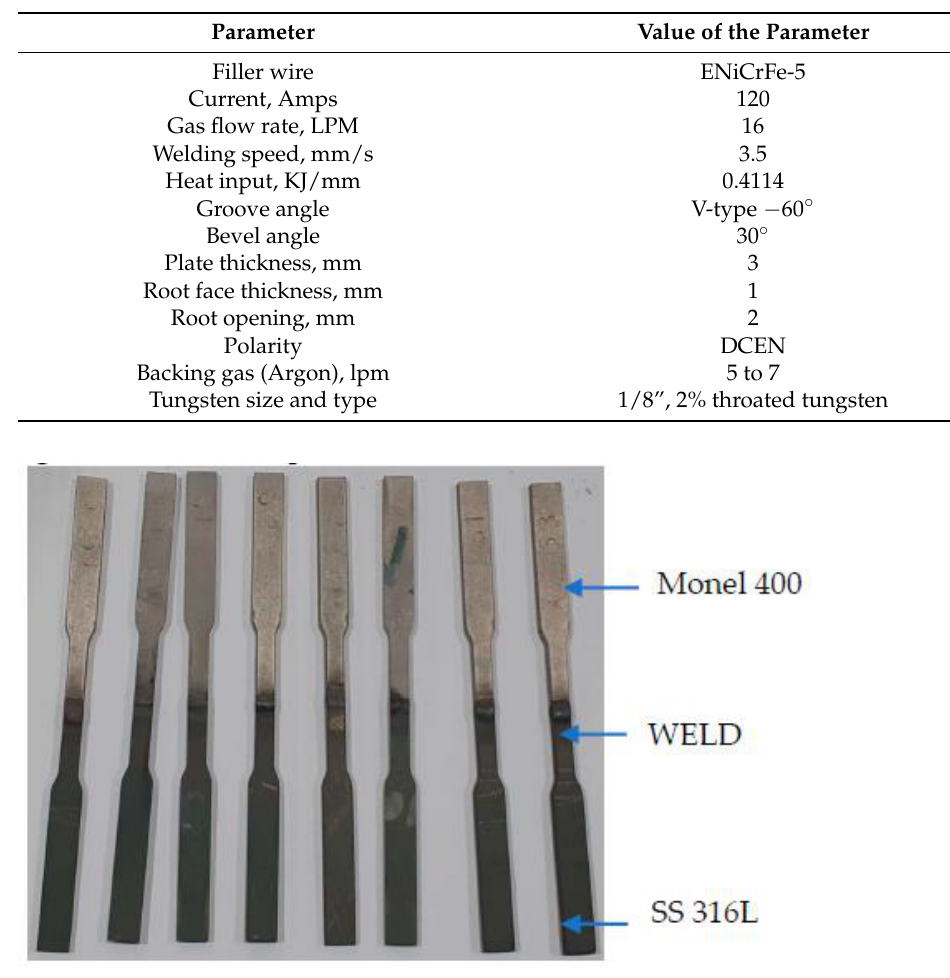
Figure 2. Tensile test specimens